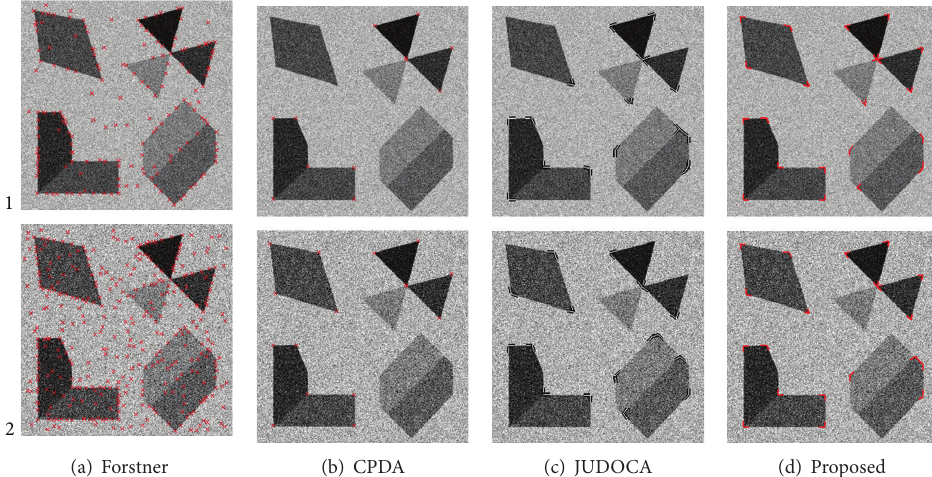
Figure 4: Junction points detection results under different noise conditions. From row 1 to row 2, the random noises added is 1% and 1.2%, respectively. The results of the four methods are shown as the images from column (a) to column